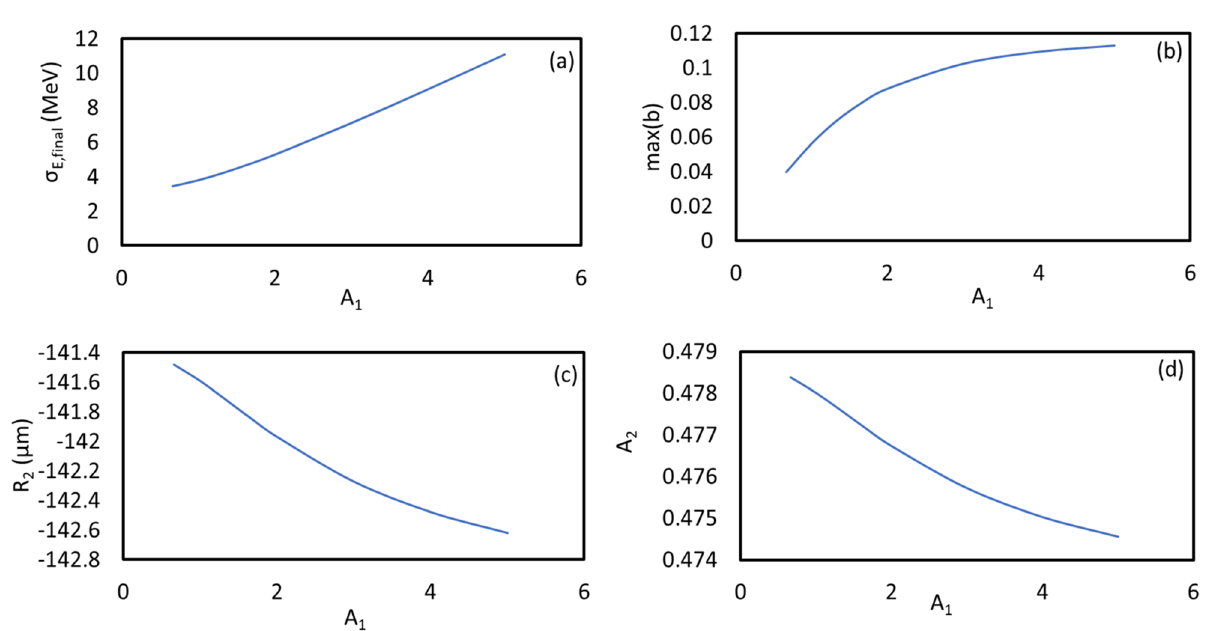
Figure 6. ( a ) The final effective RMS energy spread, ( b ) the maximal bunching, ( c ) the momentum compaction of chicane 2, and ( d ) the energy modulation of stage 2 as a function of the energy modulation of stage 1 are plotted,